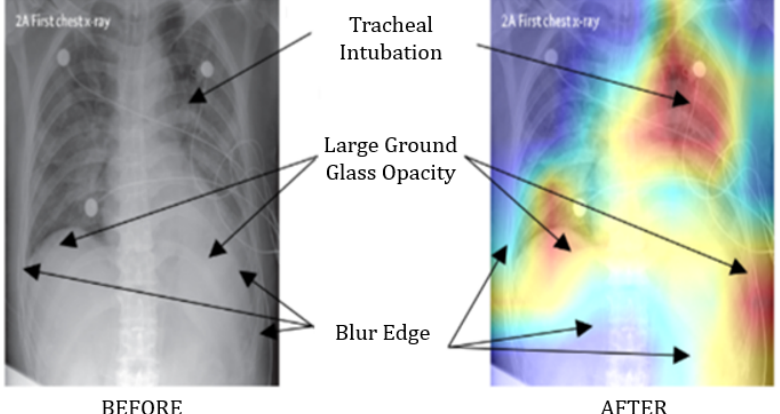
Figure 2. The extraction of unnecessary or irrelevant features was reduced significantly following the analysis of a larger dataset